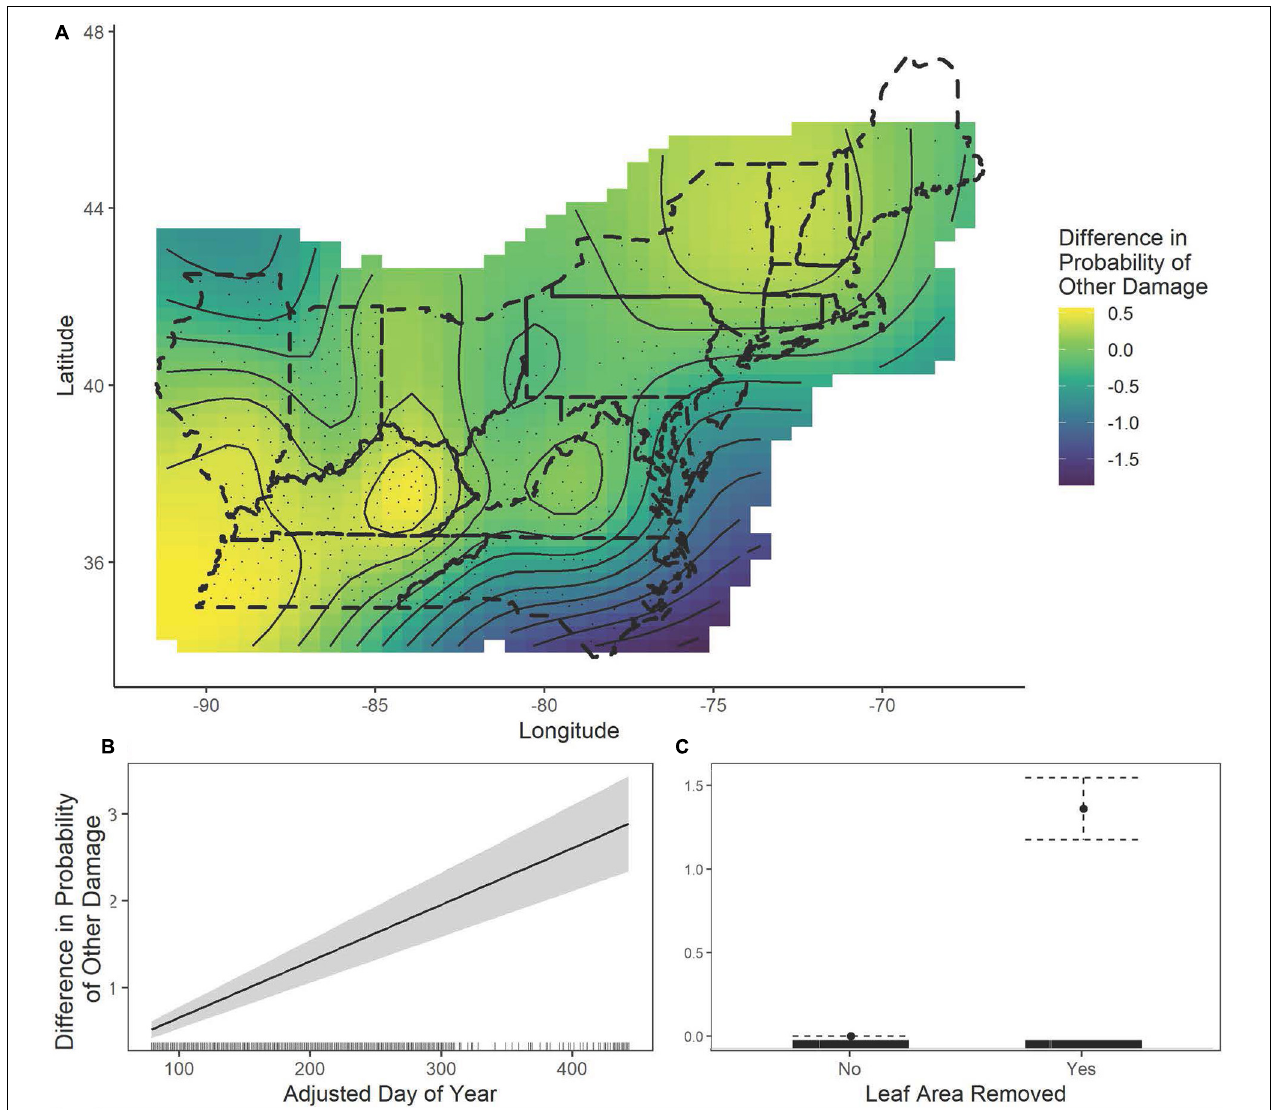
FIGURE 9 | The estimated contributions of the fitted smooths of latitude and longitude (A) , the adjusted day of year (B) and leaf area removal (C) to the General Additive Model of the probability of damage other than leaf chewing. In figure (A) , the dashed lines show the United States state boundaries in the included regions, while the solid lines show the fitted smoothed curves output from the GAMs overlaid with the fitted contour showing spatial differences. In figure (B) , the solid curve while the gray regions or dotted whiskers represent the 95% confidence interval and in figure (C) the solid point shows the estimated contribution while the dotted lines show the 95% confidence interval. Tick marks along the x-axis indicate the density of